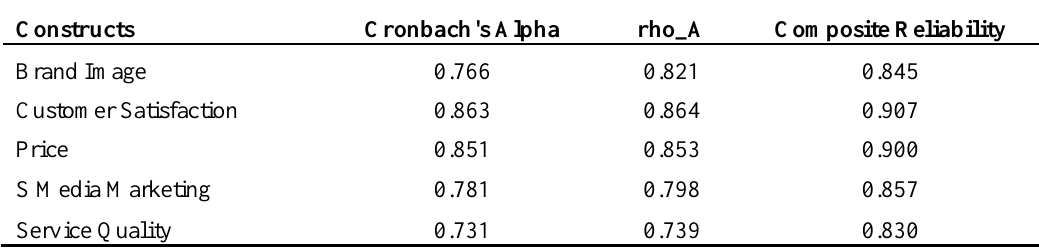
Table.6. Reliability